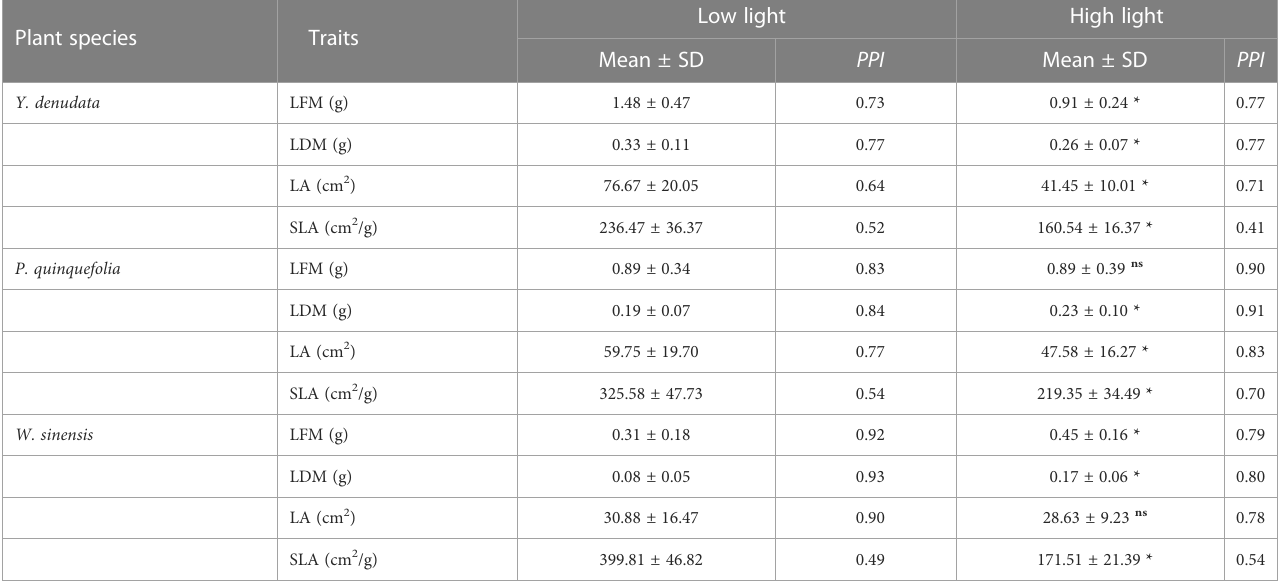
TABLE 2 The difference and phenotypic plasticity index ( PPI ) of urban plant leaf traits in different light habitats.